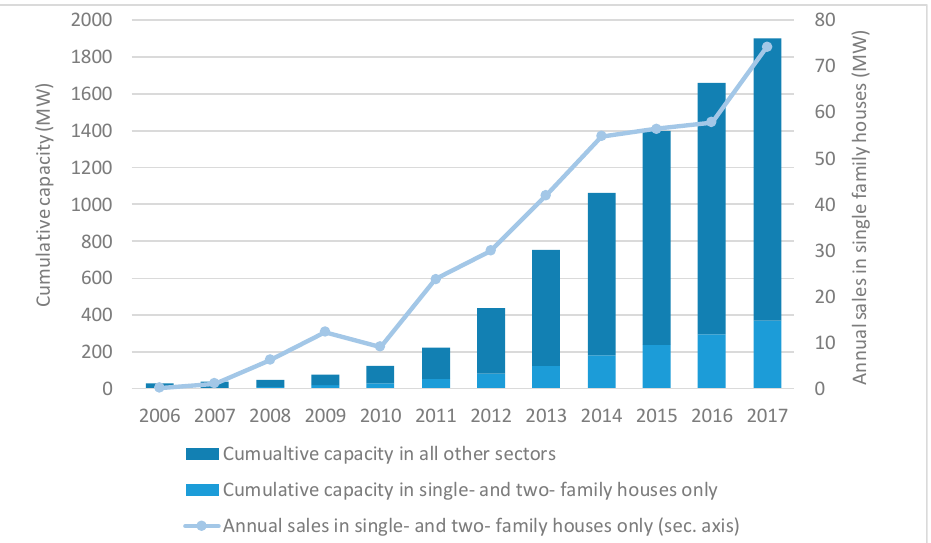
Figure 3. Annual sales (right axis), the cumulative installed capacity of solar PV in single- and two-family houses and comparison with the total cumulative installed capacity of solar PV (left axis) in Switzerland (own illustration based on [6]).